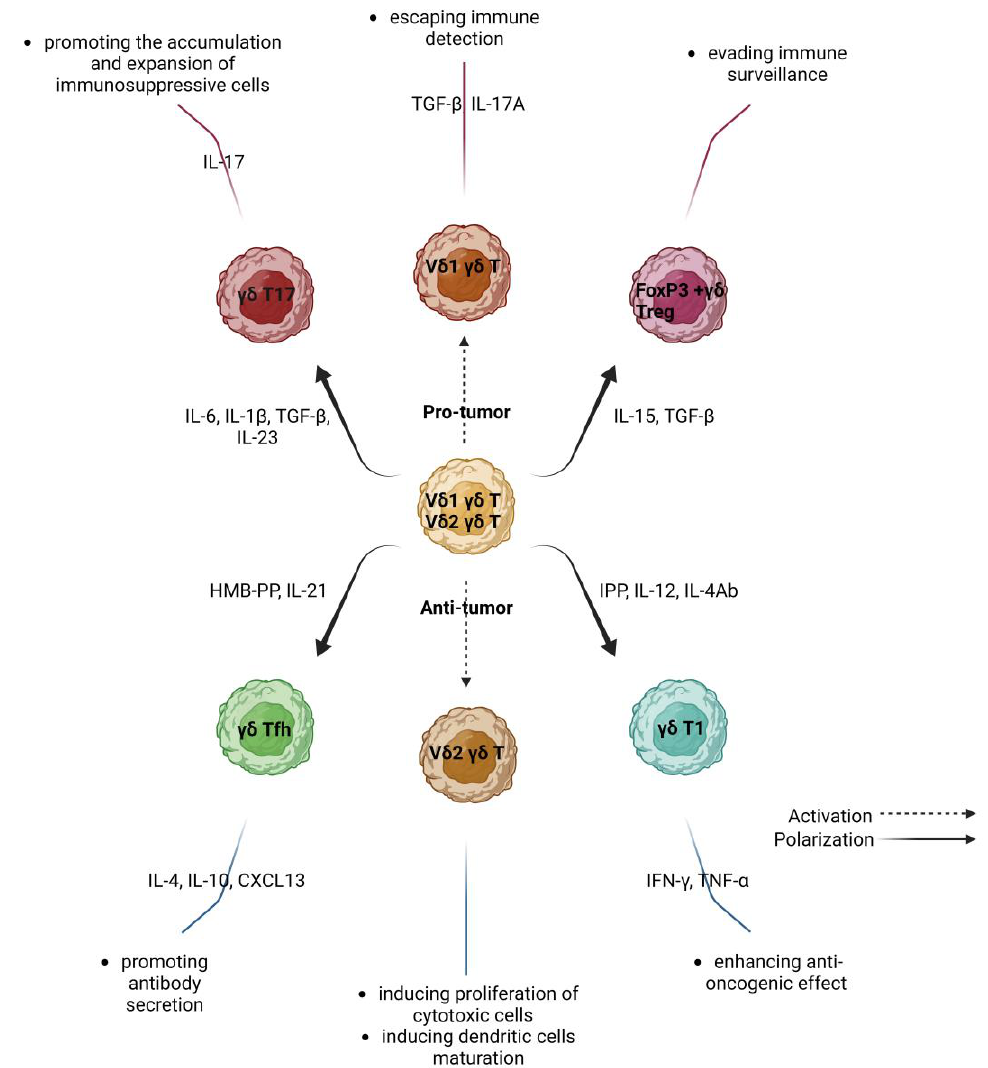
Figure 1. Subpopulations of gamma delta T lymphocytes and their activity in